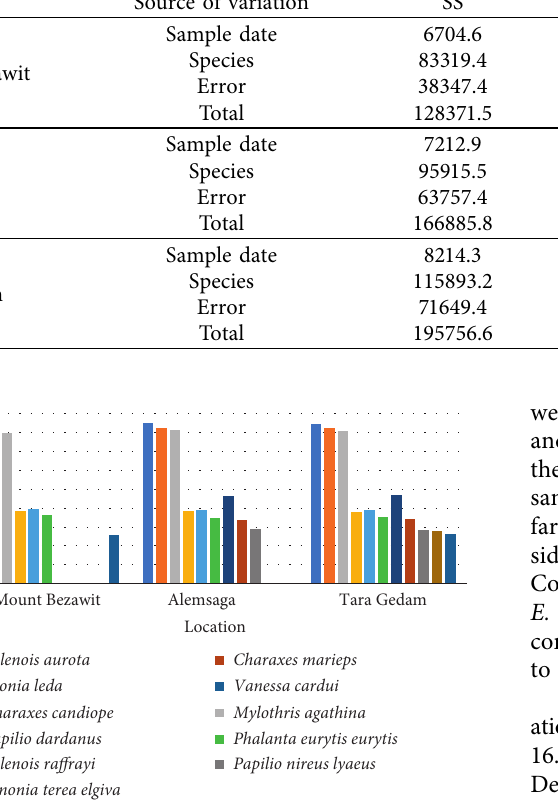
Figure 3: Abundance of butterfly species in the three study sites (Mount Bezawit, Alemsaga, and Tara Gedam